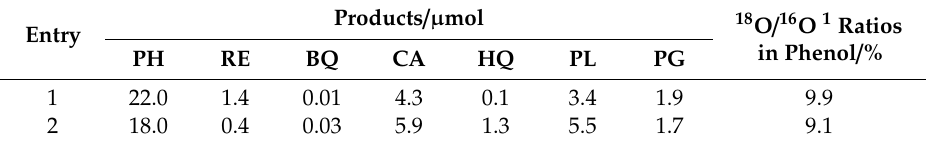
in Phenol/% PH RE BQ CA HQ in Phenol / %PH RE BQ CA HQ PL PG